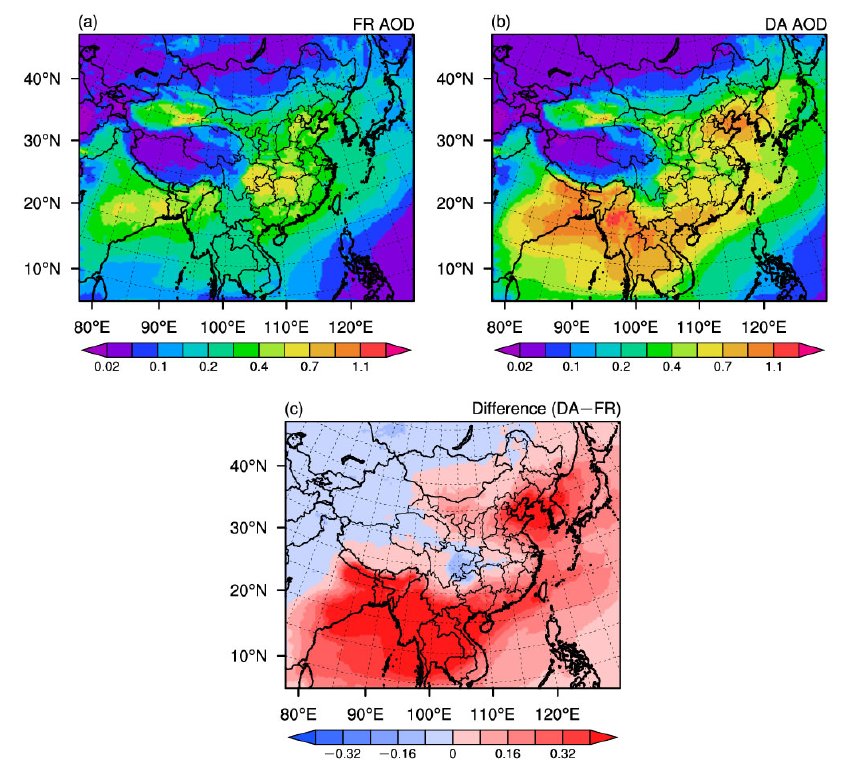
Figure 2. Spatial distributions of the mean simulated AOD in the ( a ) FR, ( b ) DA experiments, and ( c ) their difference (AOD in DA minus that in the FR experiment) from 8 to 22 March 2021.